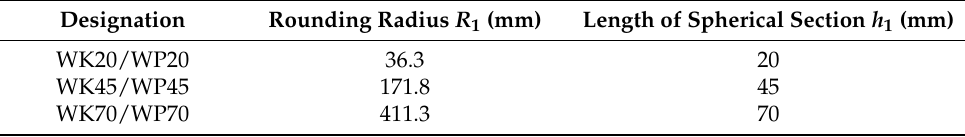
Table 2. Geometric parameters of WK and WP